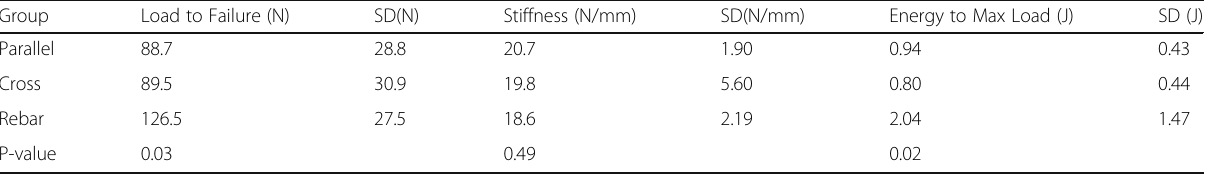
Table 5 Medial Meniscus Biomechanical Data of 2 parallel stitches, Cross Stitch and Rebar Repair Group Load to Failure